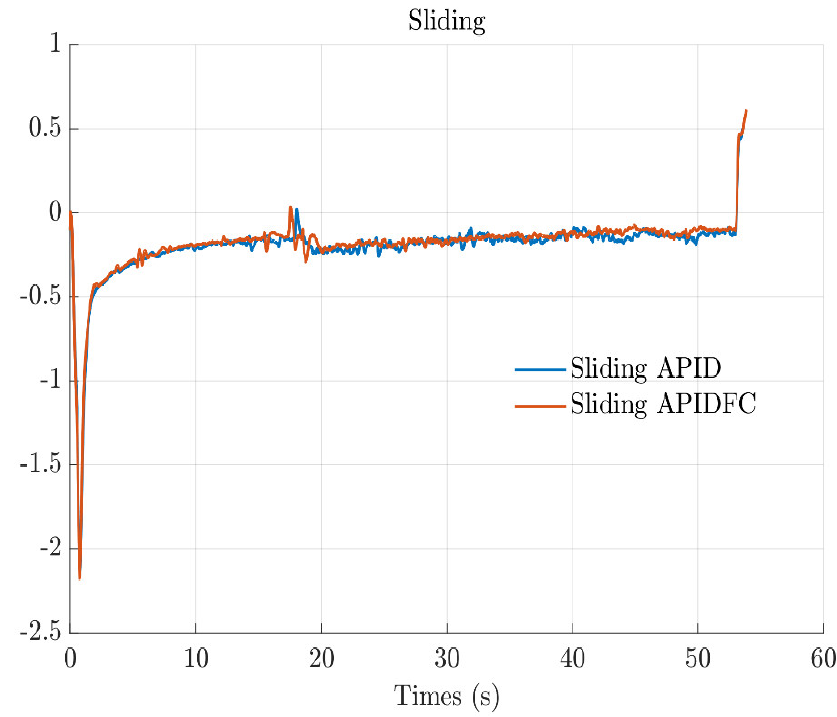
Figure 24. Sliding manifold for APID and APIDFC controllers.